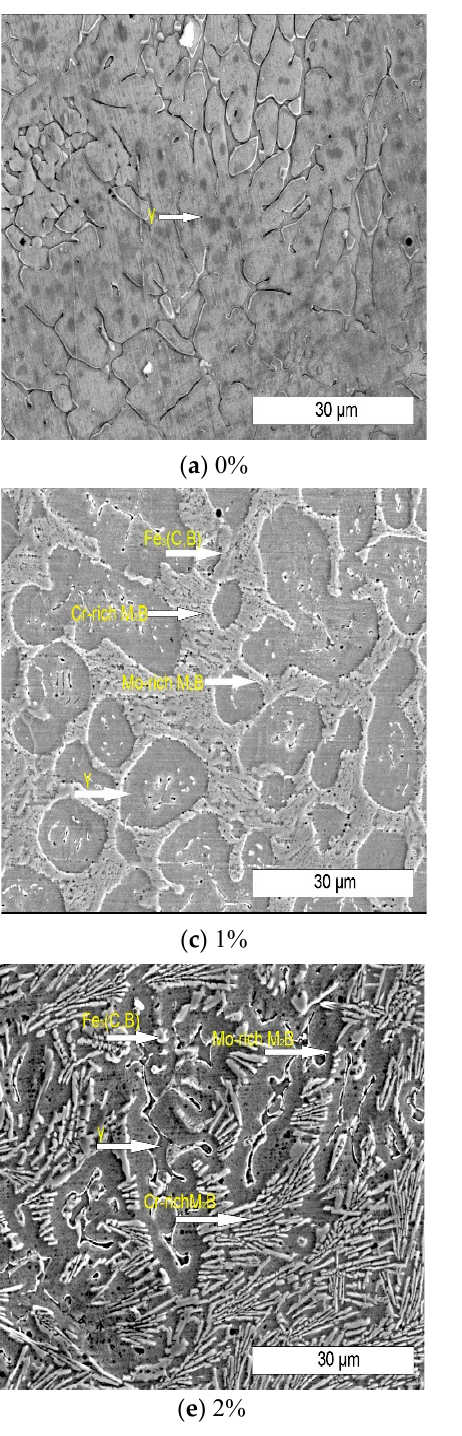
Figure 4. The microstructure of surfacing alloy with different B content.